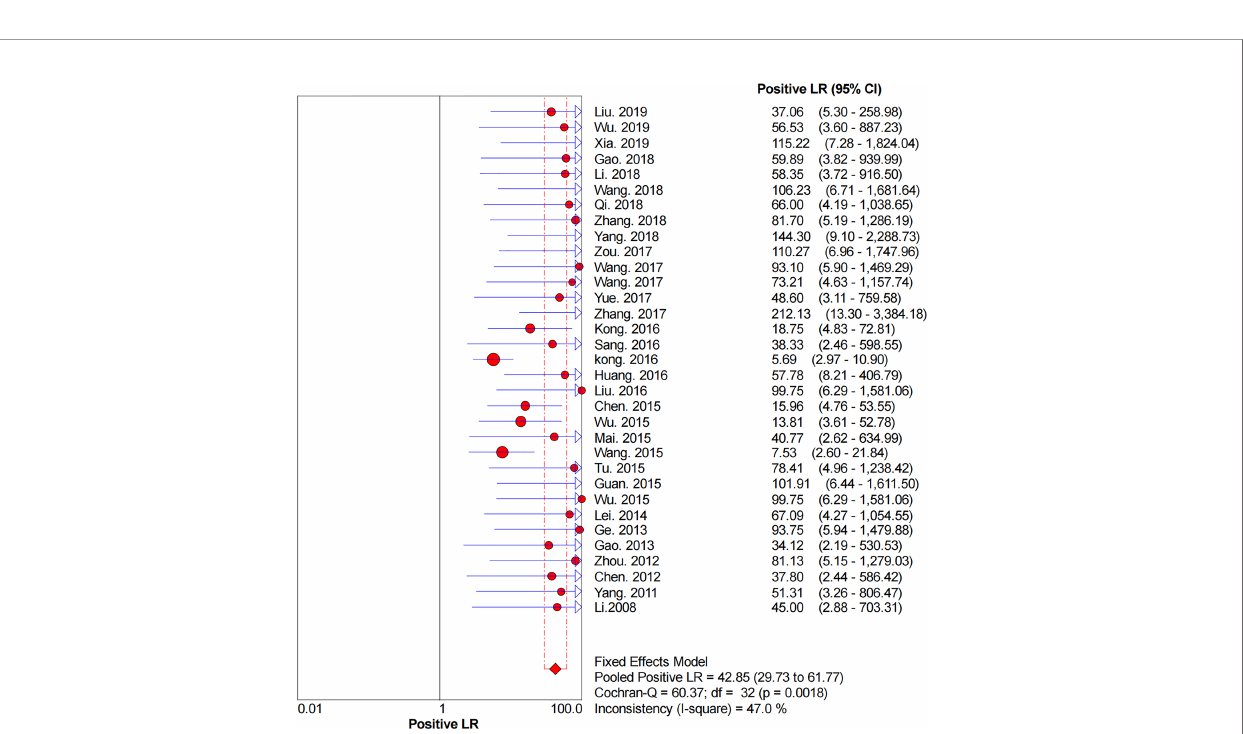
Frontiers in Oncology |